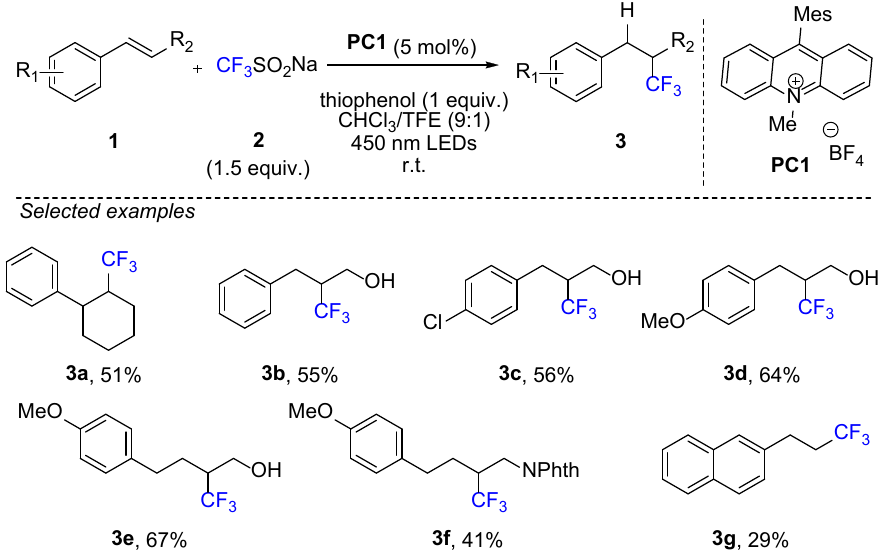
Figure 1. Hydrotrifluoromethylation of styrenes developed by the group of Nicewicz.